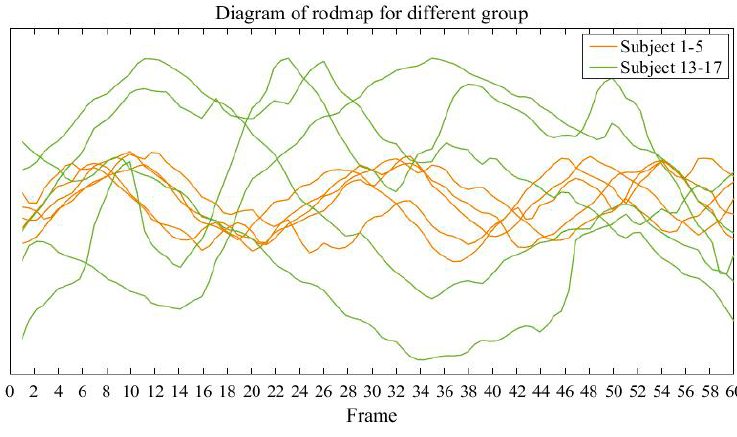
Figure 6. Comparison of the roadmap for different groups.